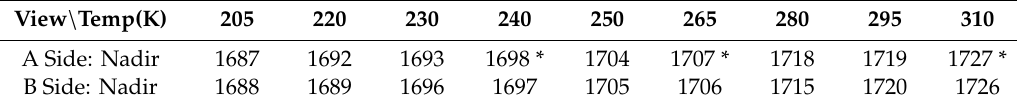
Table 5. Tests used for determining the AIRS V5 radiometric calibration coe ffi cients. LABB at nadir.